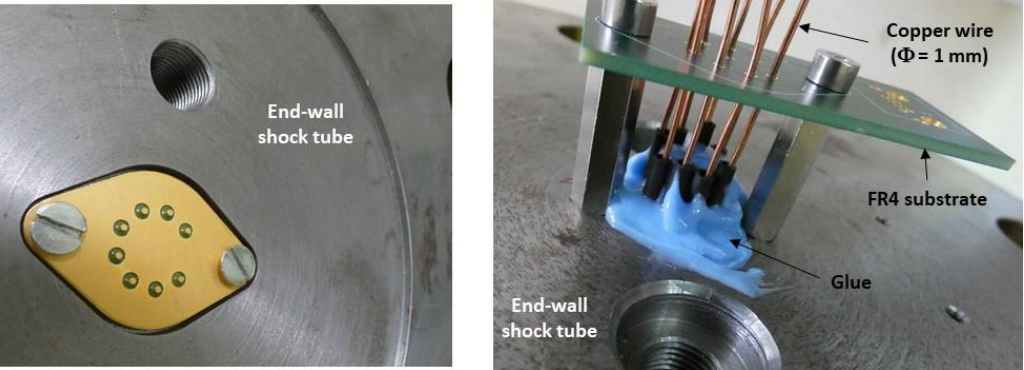
Figure 18. View of the TO3 holder embedded inside the end-wall shock-wave tube ( left ) and the electrical interconnection outside the end-wall shock-wave tube ( right ).